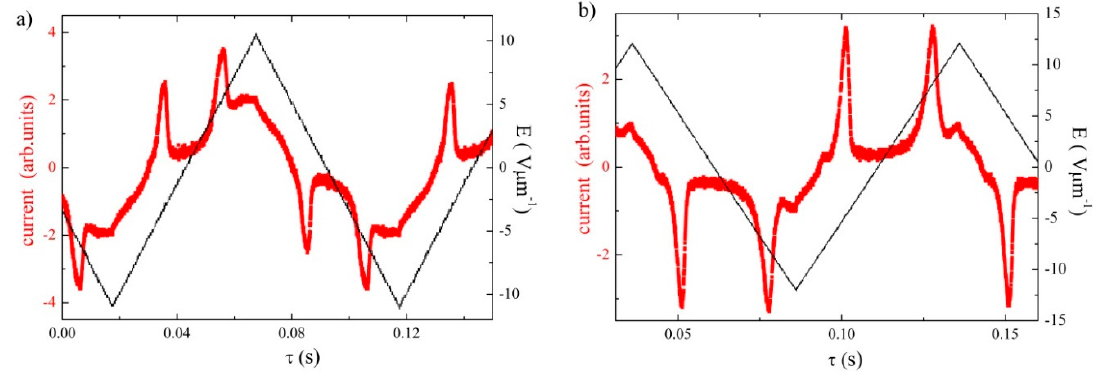
Figure 5. Switching current profile for ( a ) Ic at T = 95 °C, and ( b ) for Id at T = 96 °C.